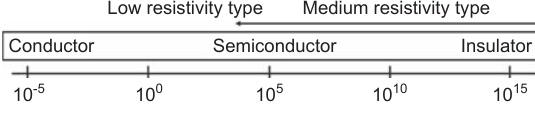
Figure 9 Electrical resistance range (adapted from [25]